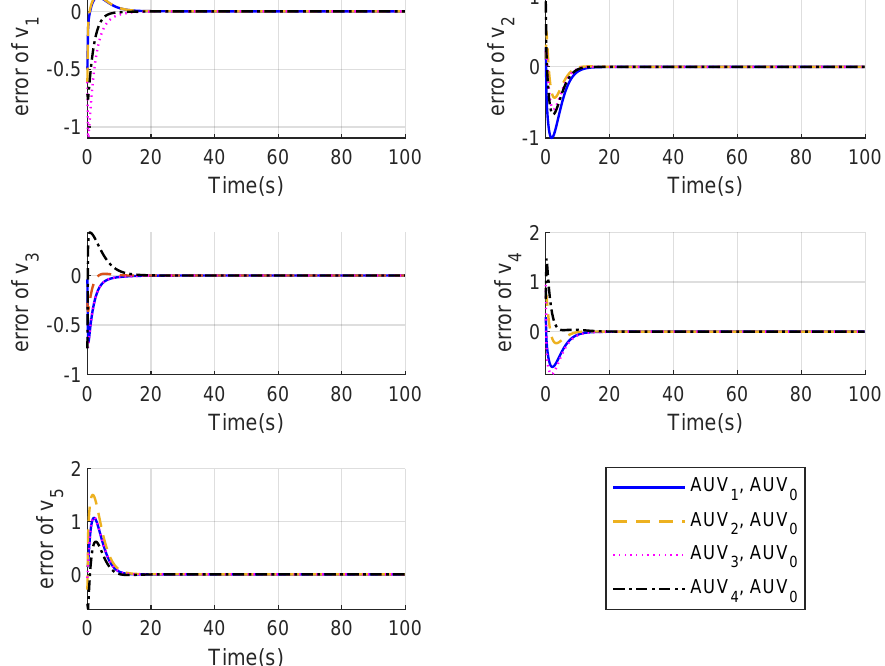
Figure 4. Errors of velocity state under ideal communication topology without